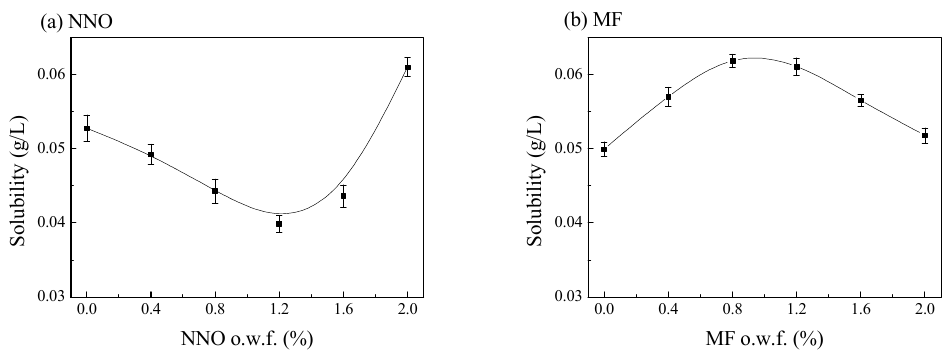
Figure 5. Influence of NNO ( a ) and MF ( b ) on the solubility of disperse red 177 in silicone waterless dyeing system.